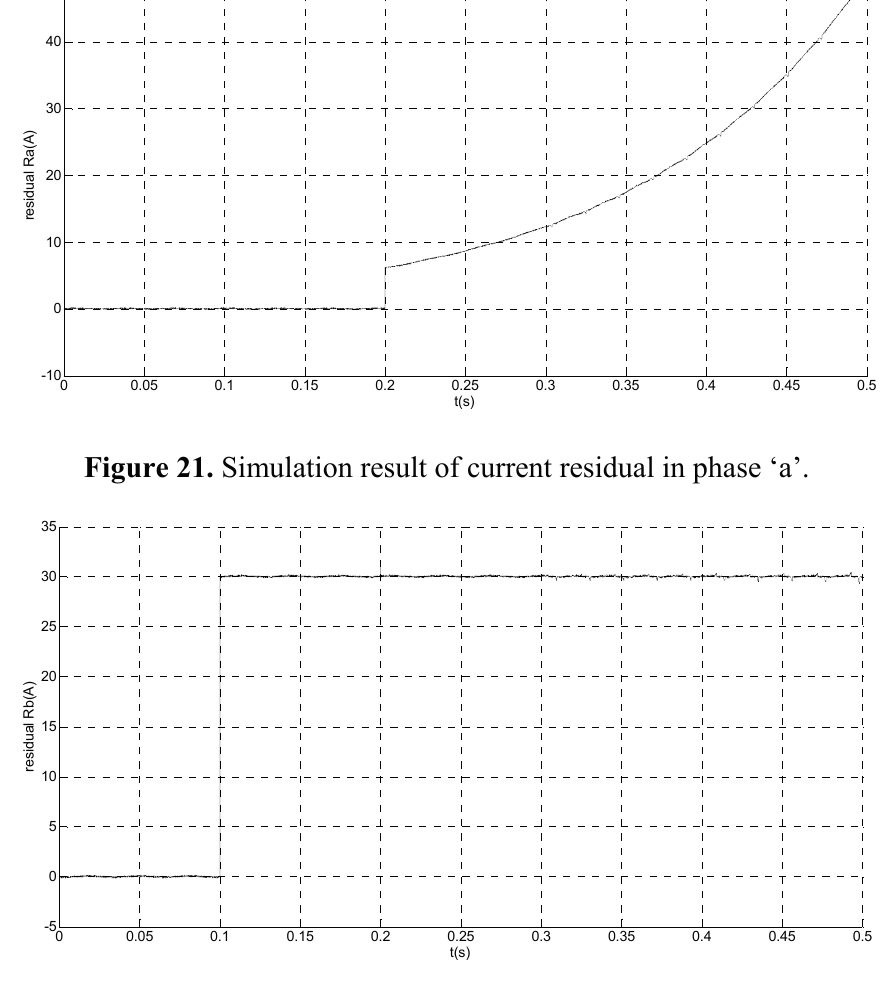
Figure 22. Simulation result of current residual in phase